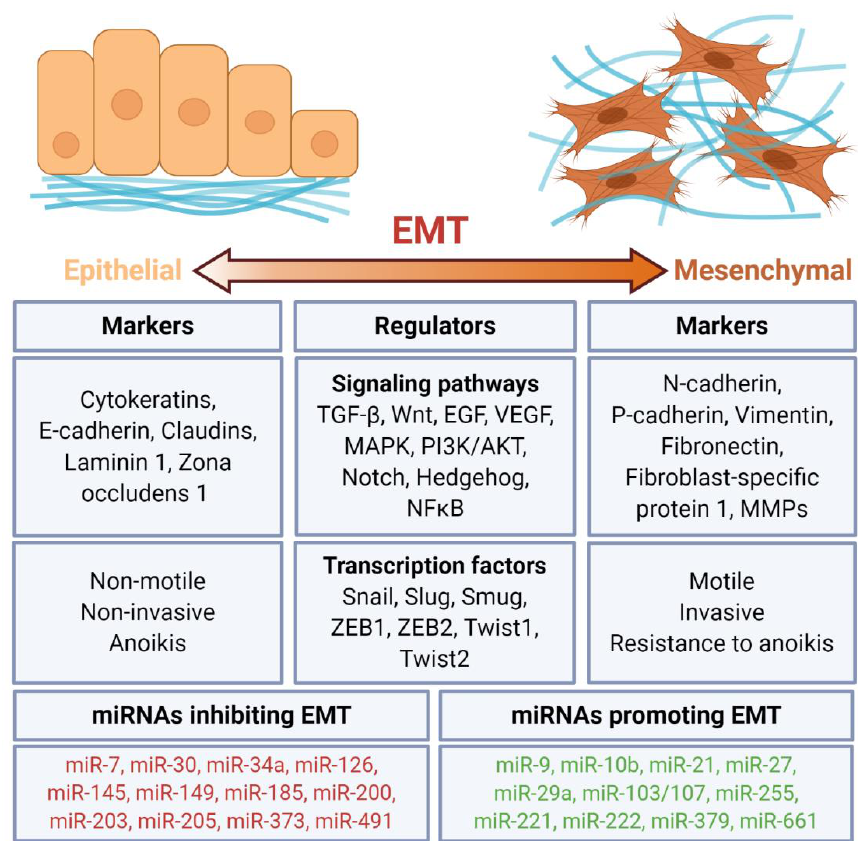
Figure 4. Regulation of epithelial–mesenchymal transition (EMT) by miRNAs. EMT is a process of the acquisition of the mesenchymal features, including motility, invasiveness, and resistance to anoikis of epithelial cells. It is regulated by multiple signaling pathways and transcription factors. Several miRNAs have been identified as either inhibiting or promoting EMT.